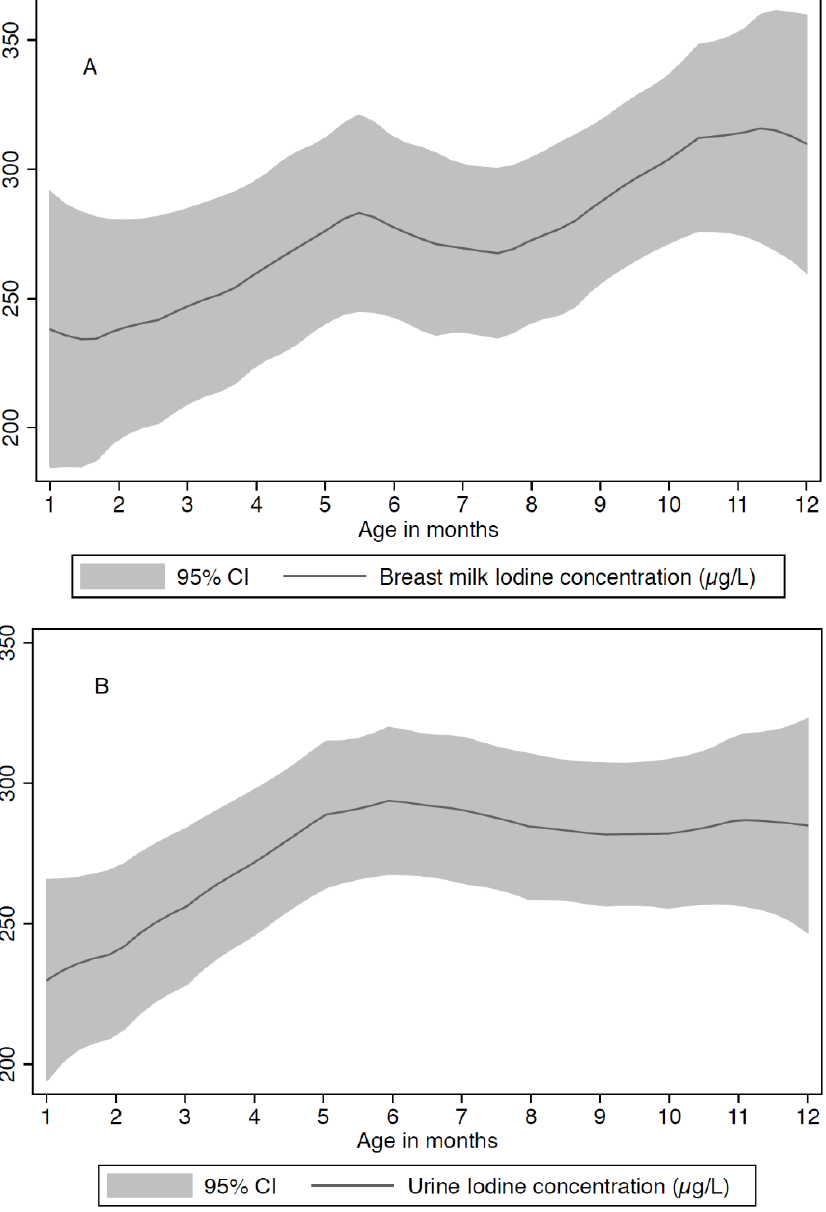
Figure 2. Association of breastmilk iodine concentration (BMIC) ( A ) and maternal urinary iodine concentration (UIC) ( B ) and time since birth (age of the child). The shaded areas represent the 95% CI of the smooth regression line.